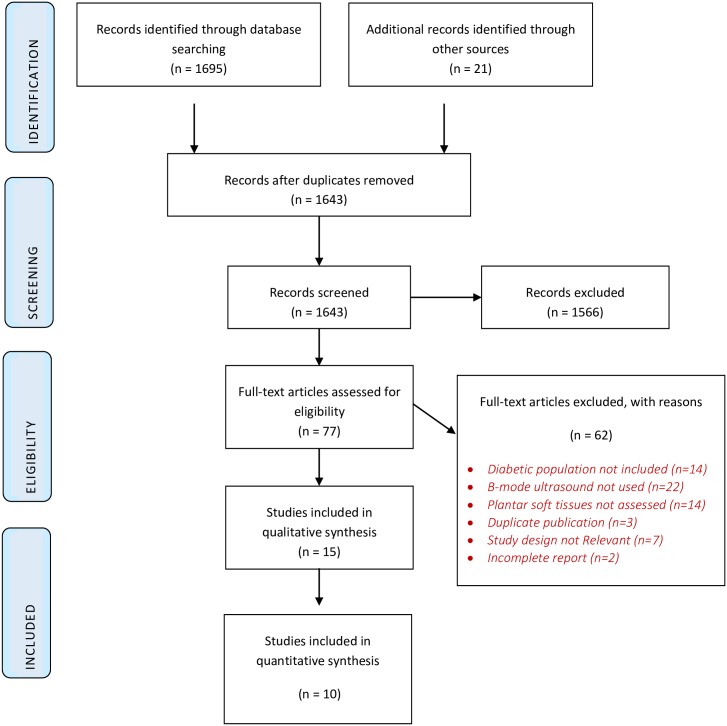
PRISMA flow diagram.